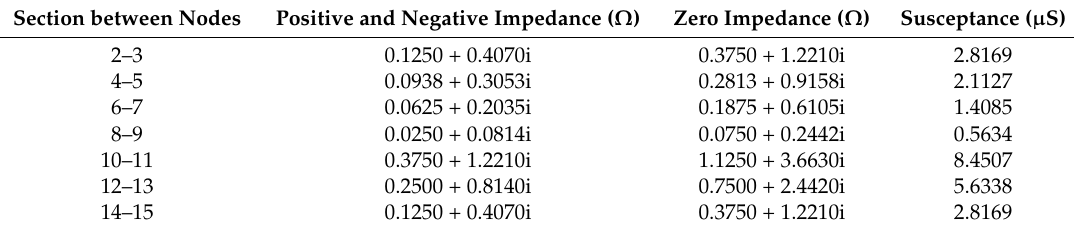
Table 2. Radial power system line parameters.